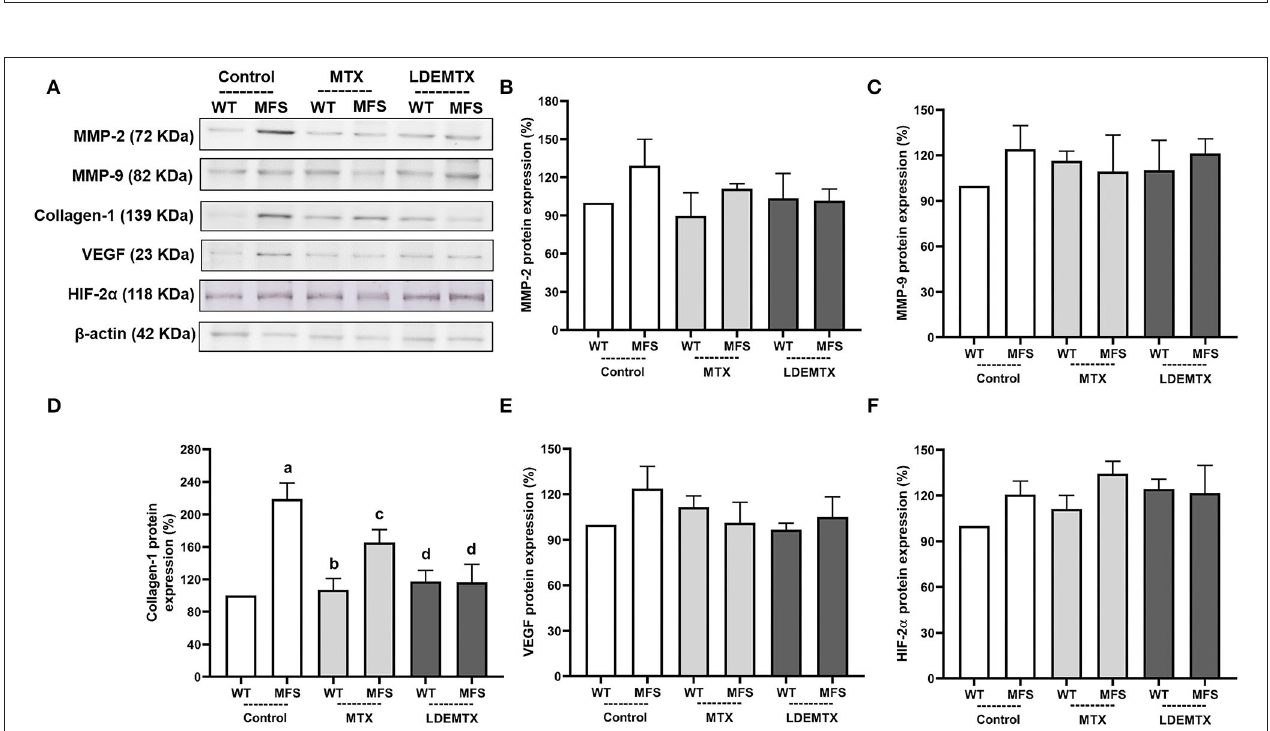
FIGURE 4 | Representative bands (A) and graphs showing western blot analysis of metalloproteinase-2 (MMP-2) (B) , MMP-9 (C) , collagen type 1 (D) , vascular endothelium growth factor (VEGF) (E) , and hypoxia-inducible factor (HIF)-2 α (F) protein expression in WT and MFS mice at 6 months of age, treated with MTX and LDEMTX. Values were normalized for the expression of β -actin, and results were expressed as a percentage of WT WT-control group means. Data are means ± SEM of a pool of aorta segments, comprising ascending aorta, aortic arch, and descending aorta ( n = 4, per group). (a) p < 0.01 vs. WT-control; (b) p < 0.01 vs. MFS-control; and (c) p < 0.05 vs.